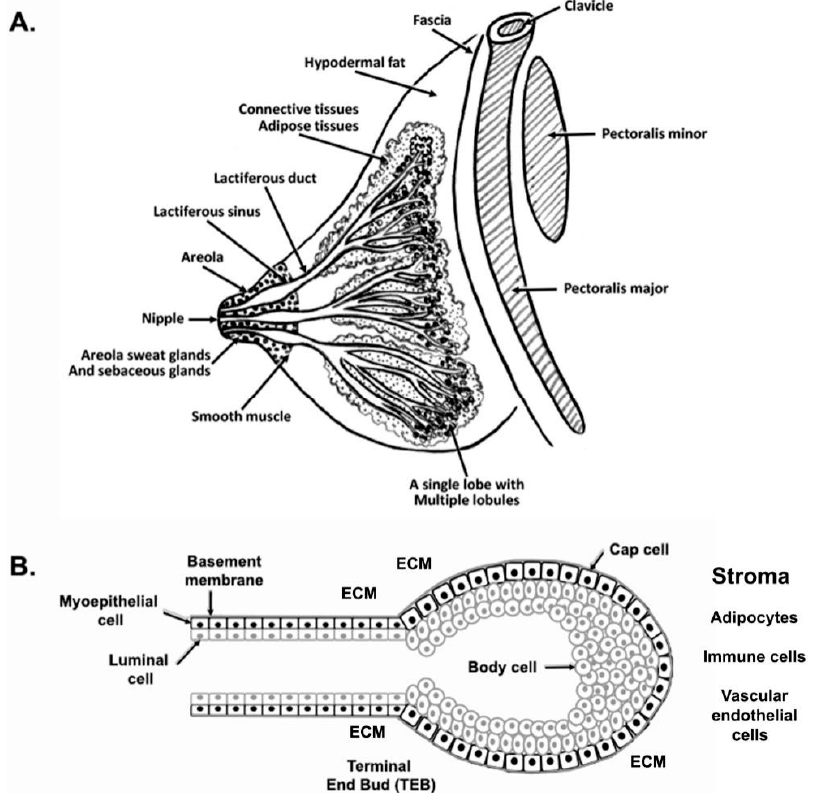
Figure 1. The mammary gland. ( A ) Schematic representation of adult human mammary gland anatomy. The mammary gland (exocrine sudoriferous or sweat gland) is located on the ventral chest wall superficial to the pectoralis muscles. The basic components of a mature mammary gland are the alveoli (hollow cavities, a few millimeters large) lined with milk-secreting cuboidal cells and surrounded by myoepithelial cells. These alveoli join together to form lobules surrounded by adipose and connective tissues. Each lobule has a lactiferous duct that drains into openings in the nipple through lactiferous sinus. The nipple is surrounded by the pigmented areola with sweat and sebaceous glands. ( B ) Schematic representation of a terminal end bud (TEB). Mature ducts are comprised of luminal epithelial cells surrounded by contractile myoepithelial cells, fibrous connective tissue, and variable amounts of adipose tissue. At puberty, these swell into TEBs. TEBs consist of multiple layers of body cells and a single layer of cap cells at the leading edge. The subtending ducts are surrounded by a variety of stromal cells or connective tissues with extracellular matrix (ECM) protein supports the mammary glands. The major components of stromal connective tissues are adipocytes, fibroblasts, vascular endothelial cells, a variety of innate immune cells (both macrophages and mast cells), and nerves. The fatty stroma is the supportive network for the epithelium bi-layered structure and provides nutrients, blood supply, and immune defenses besides the physical structure to the gland. TEBs are regulated hormonally by estrogens (E2) and progesterone (P4) from the corpus luteum and placenta, prolactin (PRL) from the anterior pituitary, and oxytocin from the posterior pituitary gland. TEBs respond to autonomic nervous system